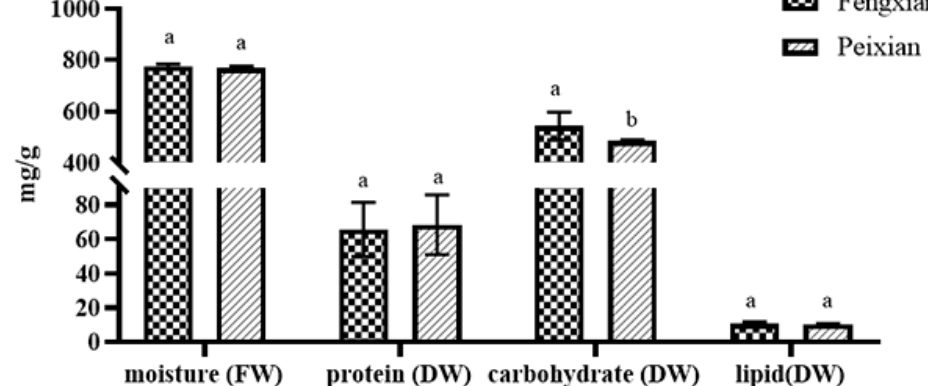
Figure 1. Moisture, protein, carbohydrate, and lipid contents of burdock root samples in Fengxian and Peixian. Different letters in the same column indicate significant differences ( p < 0.05).